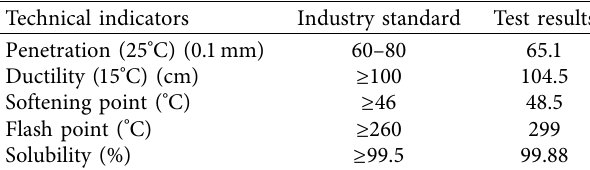
Table 1: Technical properties of 70# matrix